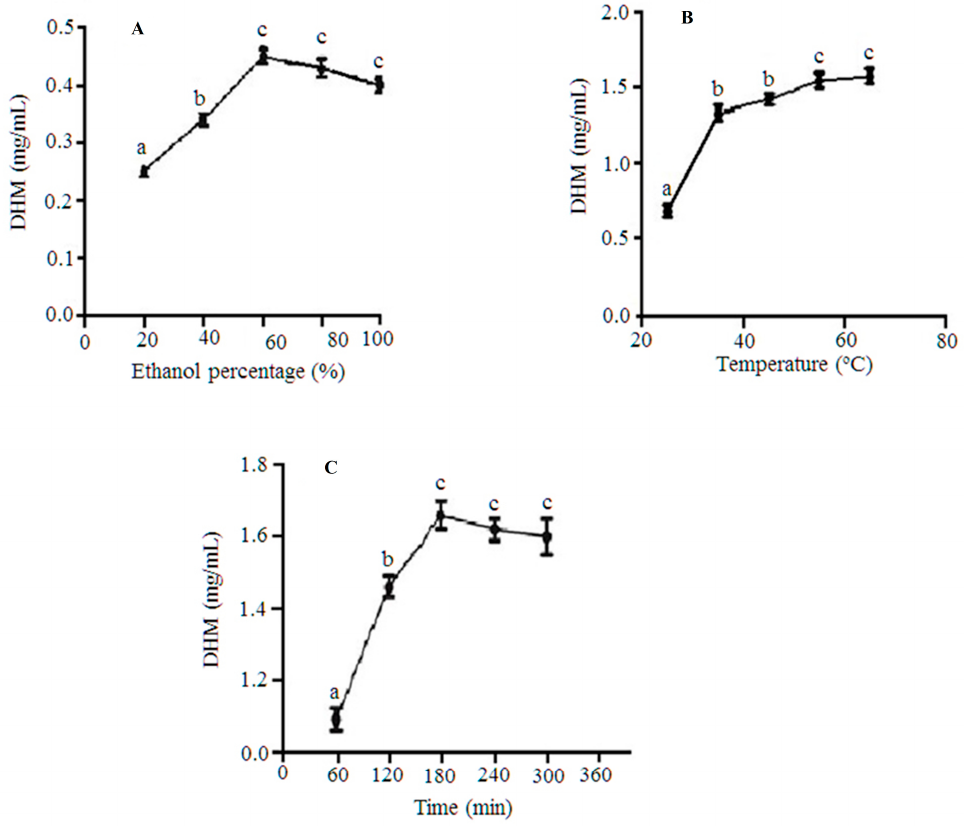
Figure 2. The effect of: ( A ) solvent composition/ethanol (%), ( B ) extraction temperature(s), and ( C ) extraction time(s) on DHM yields. Data are expressed as means ± standard deviations (SD) of three independent assays. Data points carrying different alphabetical designations represent statistically significant differences/observations ( p < 0.05). Extraction variables (when not shown) were fixed at time = 150 min, temperature = 50 °C, and ethanol = 60%.